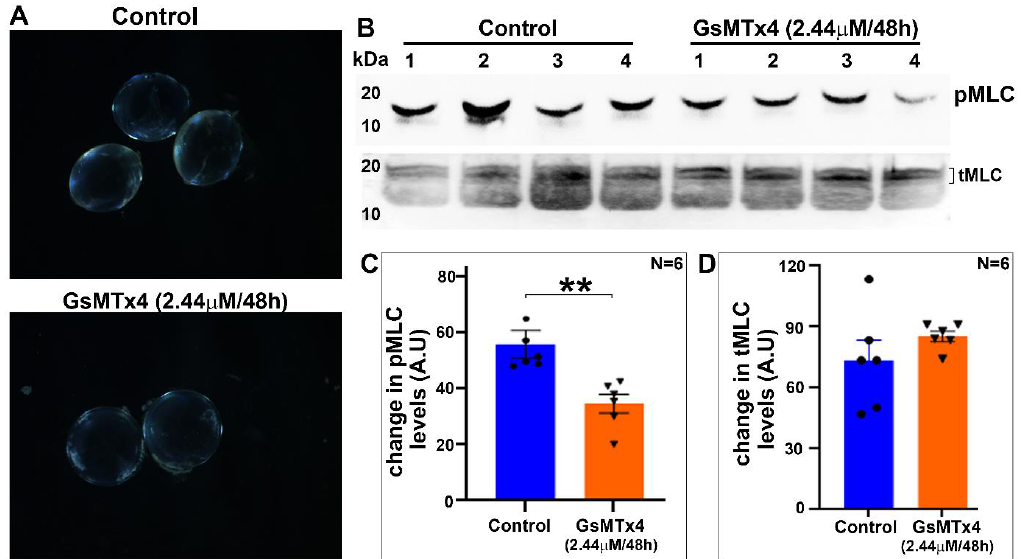
Figure 7. Decreased myosin II activity in Piezo1-inhibitor-treated lenses. ( A ) Lenses (from P30 mice) treated ex vivo for 48 hr with 2.44 µM GsMTx4, a specific inhibitor of Piezo1, remained largely transparent, with no significant change in wet weight (4.33 ± 0.156 mg/lens, n = 5) compared to the control (4.14 ± 0.036 mg/lens, n = 5) lenses. ( B , C ) Relative to the control lenses, the GsMTx4-treated (48 h) lenses showed a significant (by ~38%) decrease in their levels of phospho-MLC. ( D ) The levels of total MLC in GsMTx4-treated lenses were not different relative to the control lenses (based on densitometric evaluation of the top doublet bands of tMLC shown in panel B). Values represent Mean ± SEM. ** p < 0.01. A.U.: Arbitrary Units.